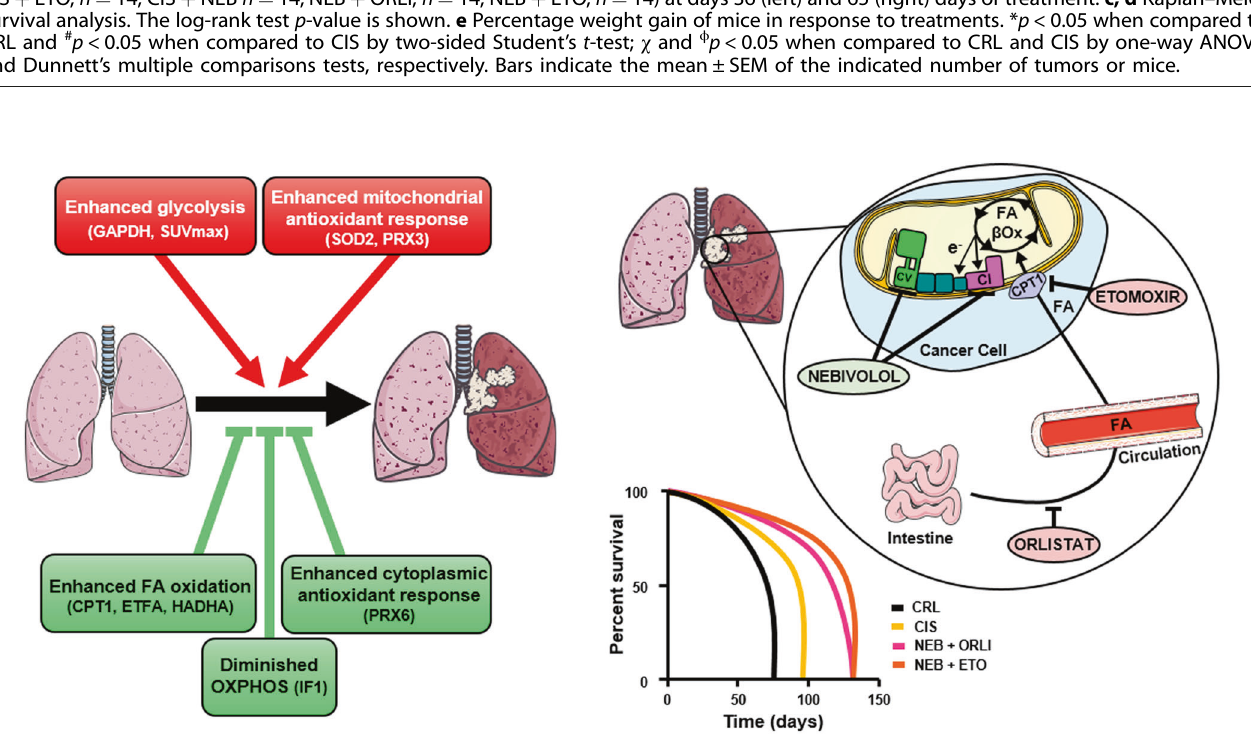
Fig. 6 Inhibition of fatty acid oxidation and OXPHOS provide an effective and better tolerated therapeutic strategy against LUAD. A549- Luc cells were injected into the fl anks of nude mice. When tumors reached a volume of ~100 mm 3 , mice were treated with saline (CRL; black trace and bars; n = 7), 5 mg kg − 1 cisplatin (CIS, yellow trace and bar; n = 7); 5 mg kg − 1 cisplatin plus 240 mg kg − 1 orlistat (CIS + ORLI, purple trace and bar; n = 7); 5 mg kg − 1 cisplatin plus 40 mg kg − 1 etomoxir (CIS + ETO; green trace; n = 7), 5 mg kg − 1 cisplatin plus 10 mg kg − 1 nebivolol (CIS + NEB, red trace and bars; n = 7), 10 mg kg − 1 nebivolol plus 240 mg kg − 1 orlistat (NEB + ORLI, pink trace and bars; n = 7) or 10 mg kg − 1 nebivolol plus 40 mg kg − 1 etomoxir (NEB + ETO, orange trace and bars; n = 7). Mice were euthanized when tumor volume reached 1500 mm 3 . a Upper panels show representative images of the bioluminescence of A549-Luc cells in mice after 0, 36, and 65 days of initiation of the treatments. b) Histograms show the quanti fi cation of light emission of the cells (CRL, n = 14; CIS, n = 14; CIS + ORLI, n = 14; CIS + ETO, n = 14; CIS + NEB n = 14; NEB + ORLI, n = 14; NEB + ETO, n = 14) at days 36 (left) and 65 (right) days of treatment. c, d Kaplan – Meier survival analysis. The log-rank test p -value is shown. e Percentage weight gain of mice in response to treatments. * p < 0.05 when compared to